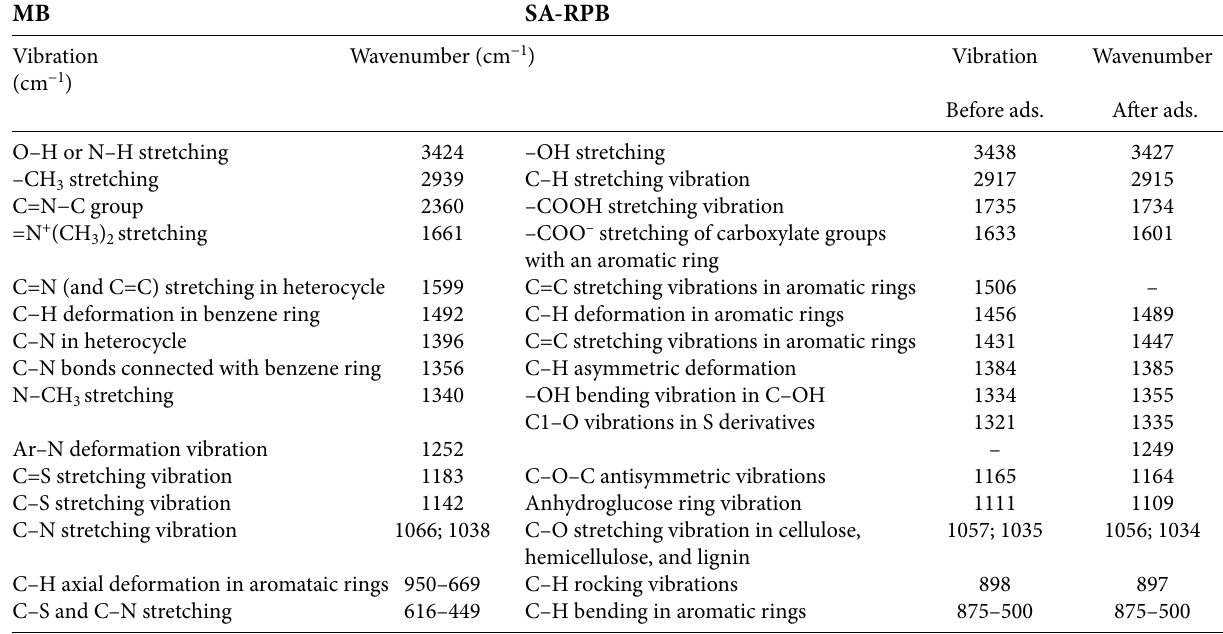
Table 8. FTIR spectral features of MB and SA-RPB before and after MB adsorption